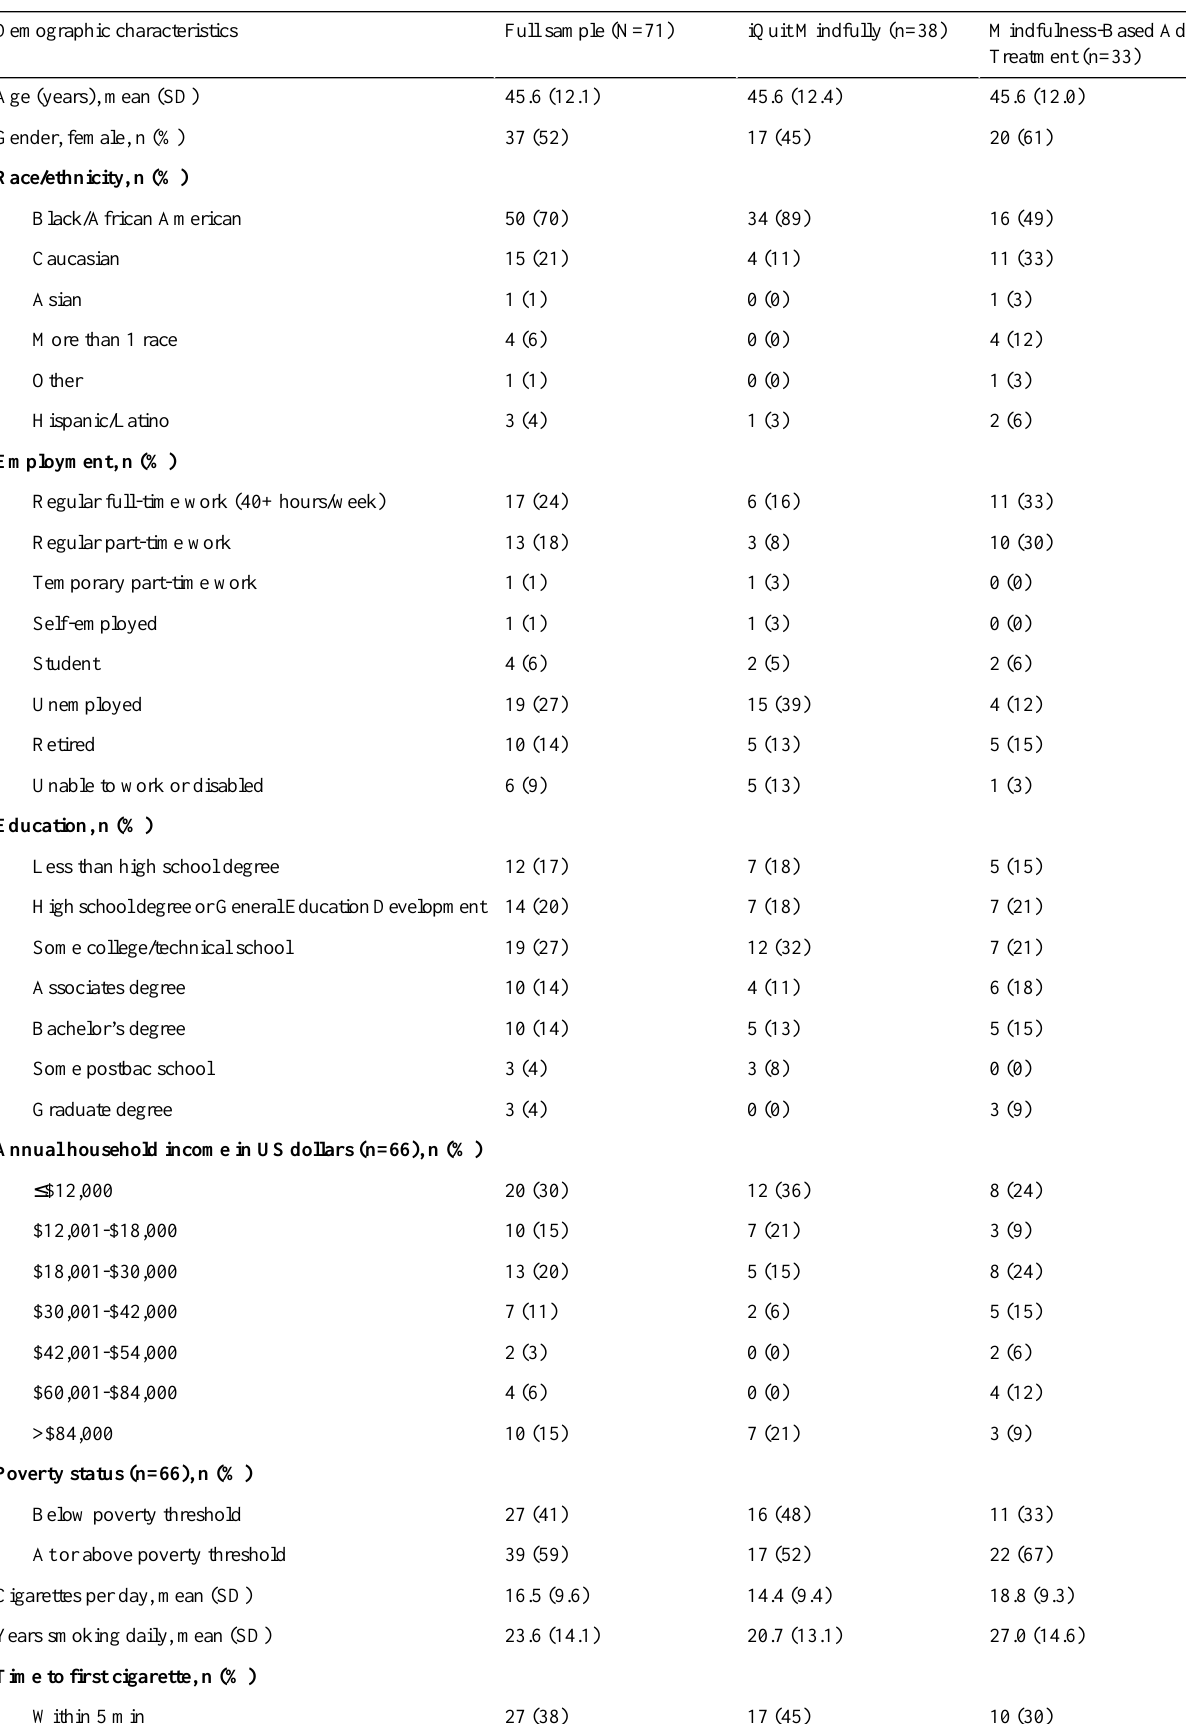
Table 1. Participants’characteristics.